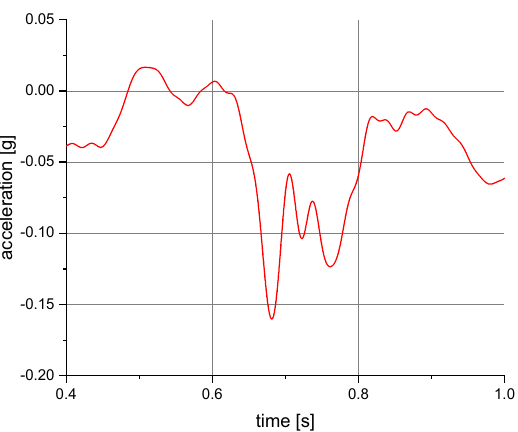
Figure 5. Acceleration as a function of time recorded during fall arrest. Test conditions: back point of the safety harness; the sensor mounted on the abdomen of the manikin.